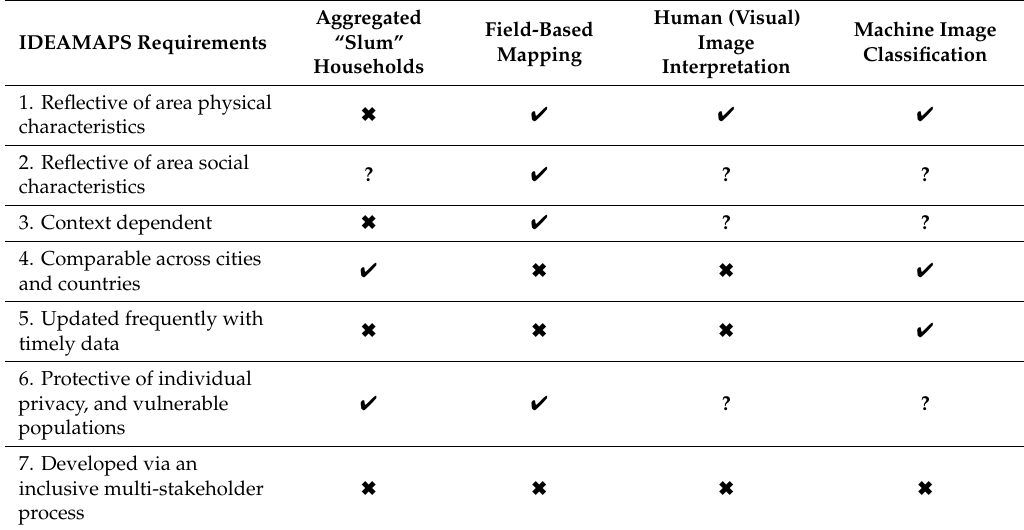
Table 2. Strengths and limitations of existing approaches to area deprivation